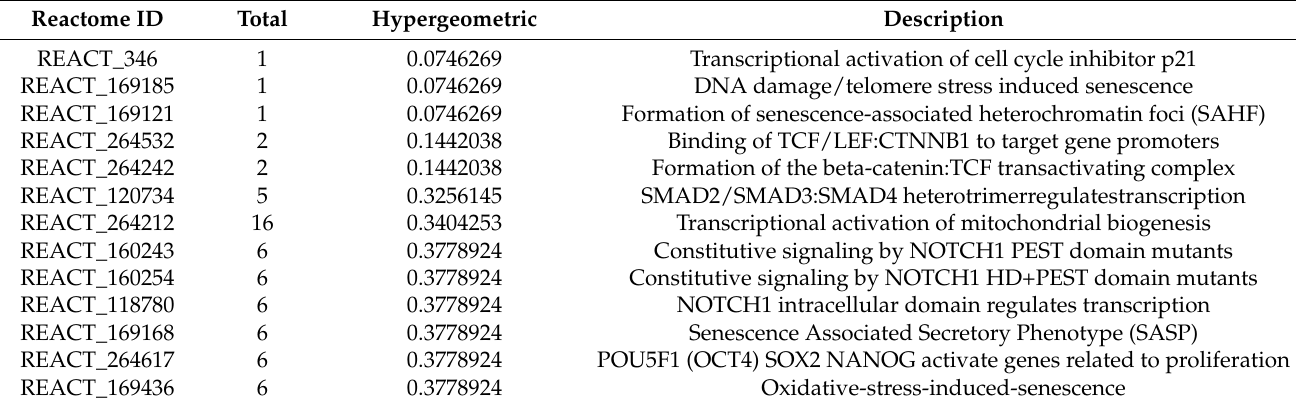
Table 1. Reactome pathways identified for overexpressed miRNA using hypergeometric